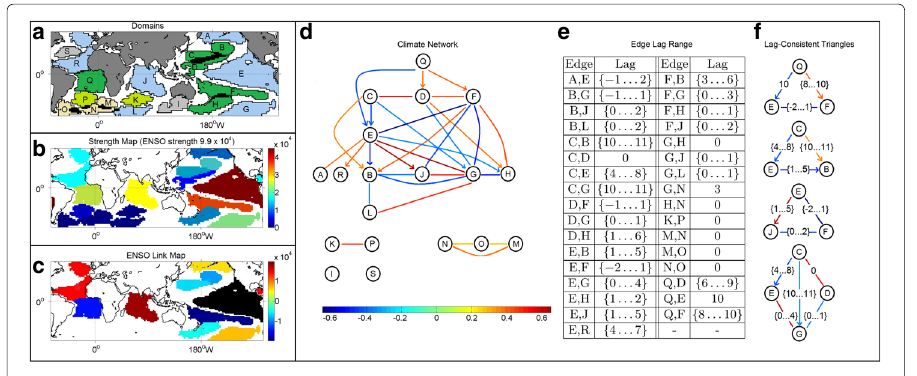
Fig. 3 a The identified domains. The color of each domain corresponds to the connected component it belongs to (the blue and green nodes belong to two different poles of the same component). b Color map for domain strength. The strength of ENSO (domain E ) is shown at the top. c Edges to and from ENSO (shown in black). d The climate network. The color of each edge represents the corresponding cross-correlation. e The lag range associated with each edge. f Examples of lag-constistent